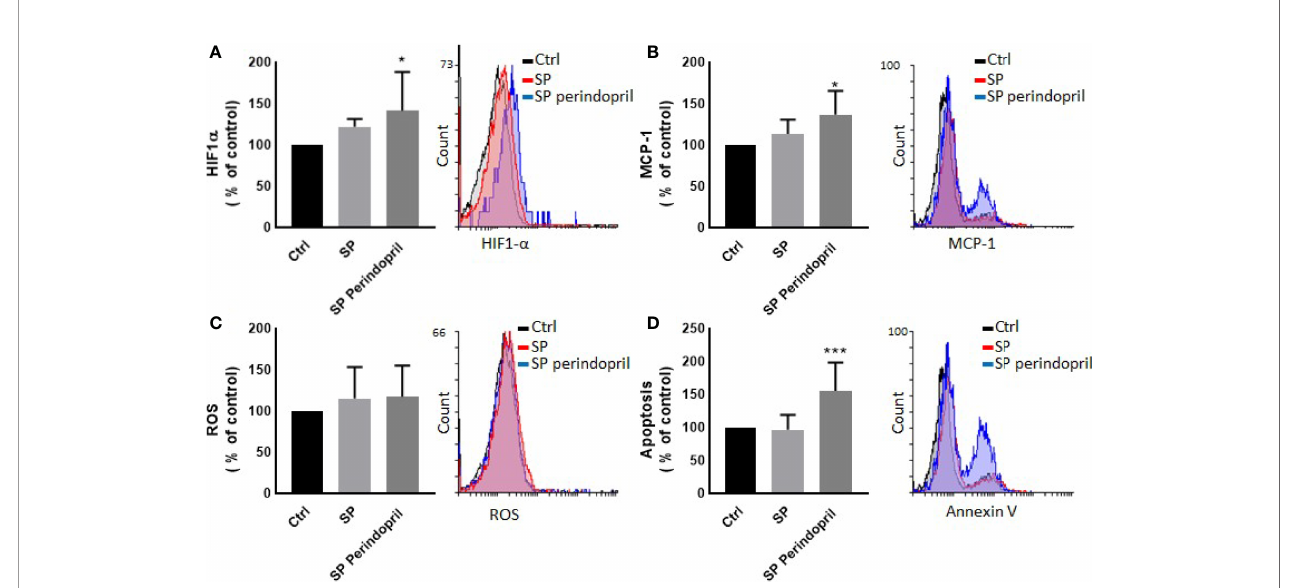
FIGURE 5 | Effect of spike (S) protein stimulation on HUVEC cells. HUVEC cells were mock treated (Ctrl), stimulated with S protein (SP) (100 µM) or SP with ACE inhibitor (SP Perindopril, 100 µM), perindopril, added 2 h before SP. (A) Hypoxia-inducible factor 1-alpha (HIF1 a ) expression. (B) Monocyte chemoattractant protein- 1 (MCP-1) expression. (C) ROS detection. (D) Apoptosis evaluated by Annexin V binding essay was measured by fl ow cytometry. The data are presented as mean ± SEM, n = 4 – 5. Ordinary one-way ANOVA followed by Dunnett ’ s test * p < 0.05, *** p <